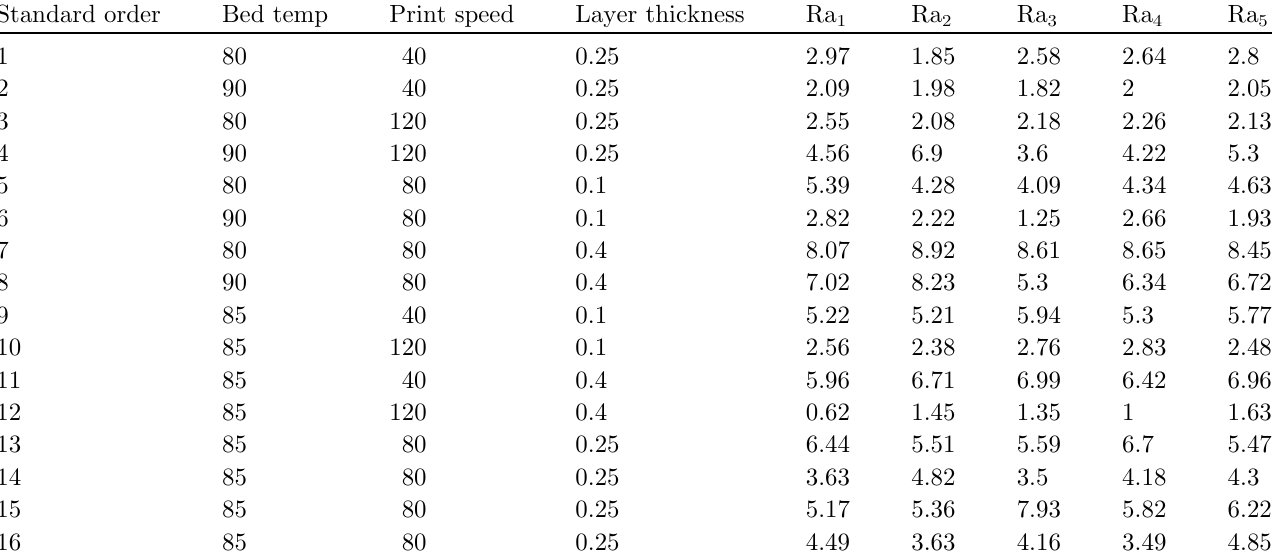
Table 3. Design matrix of bottom surface roughness. Standard